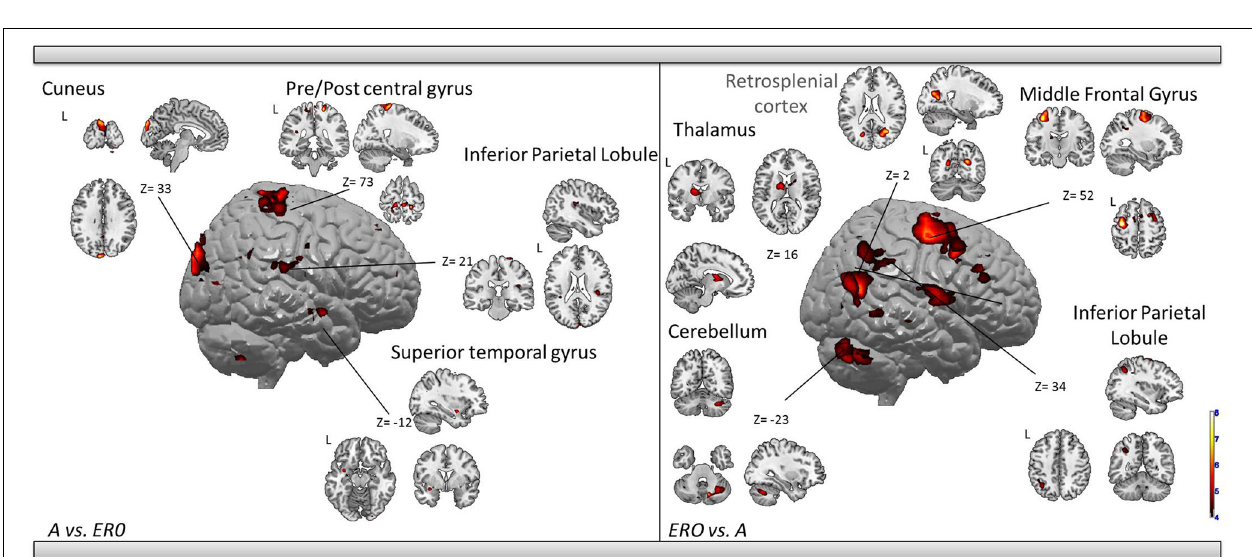
The right hippocampal activity (cluster extent k = 8 voxels), along with the superior and inferior temporal gyrus activations are highlighted on the right contrast. These clusters are projected onto 2D anatomical slices (T1-template image) in neurological convention. L is left hemisphere. The color scale represents the t -value of